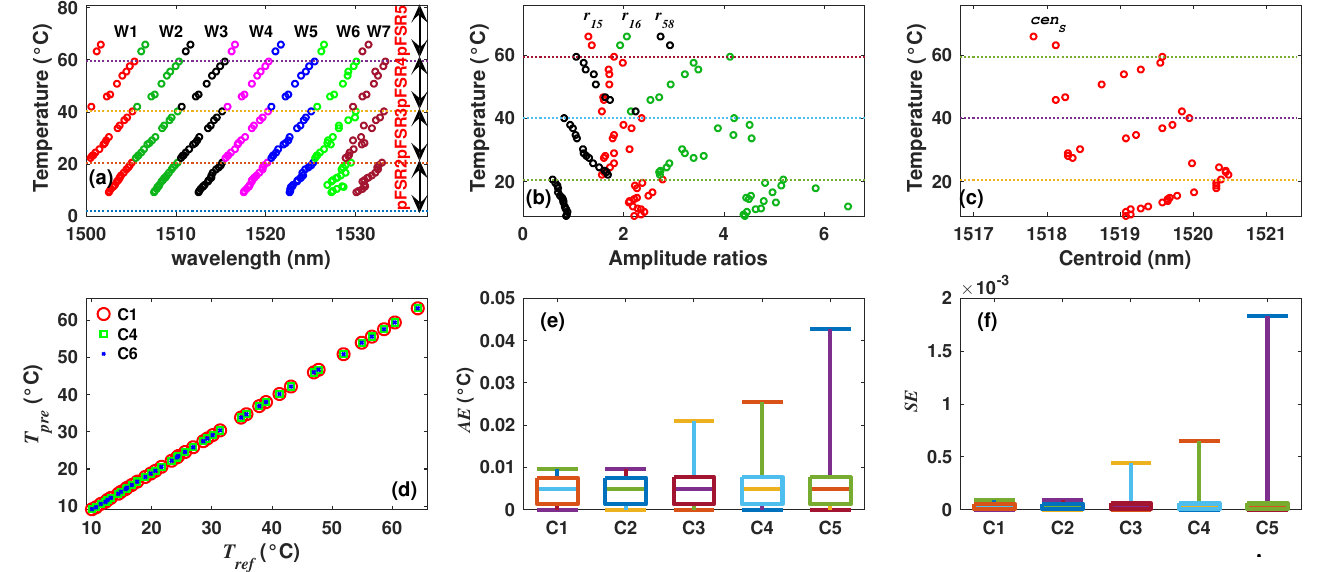
Figure 11. Experimentally measured ( a ) peaks wavelength positions, ( b ) some amplitude ratios and ( c ) centroid of the spectrum as a function of temperature of sensor 2; ( d ) comparison between T est and T ref ; ( e ) AE and ( f ) SE distributions of the T est obtained considering different input